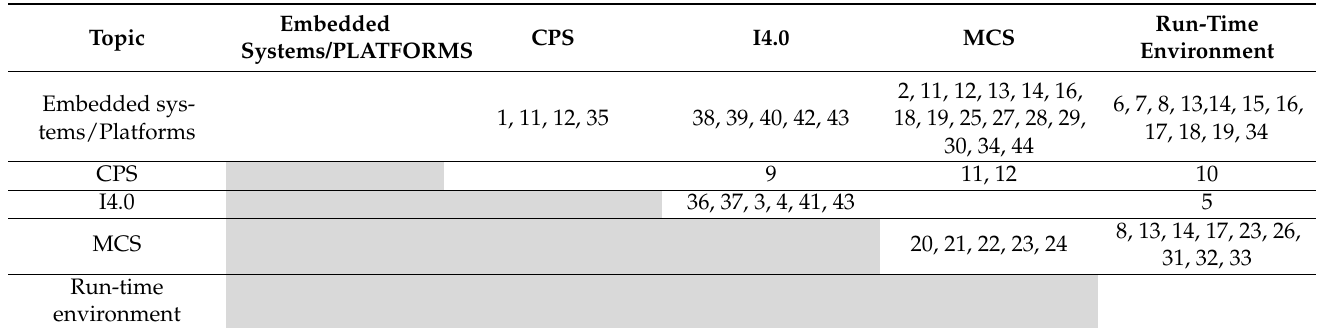
Table 1. References organized by